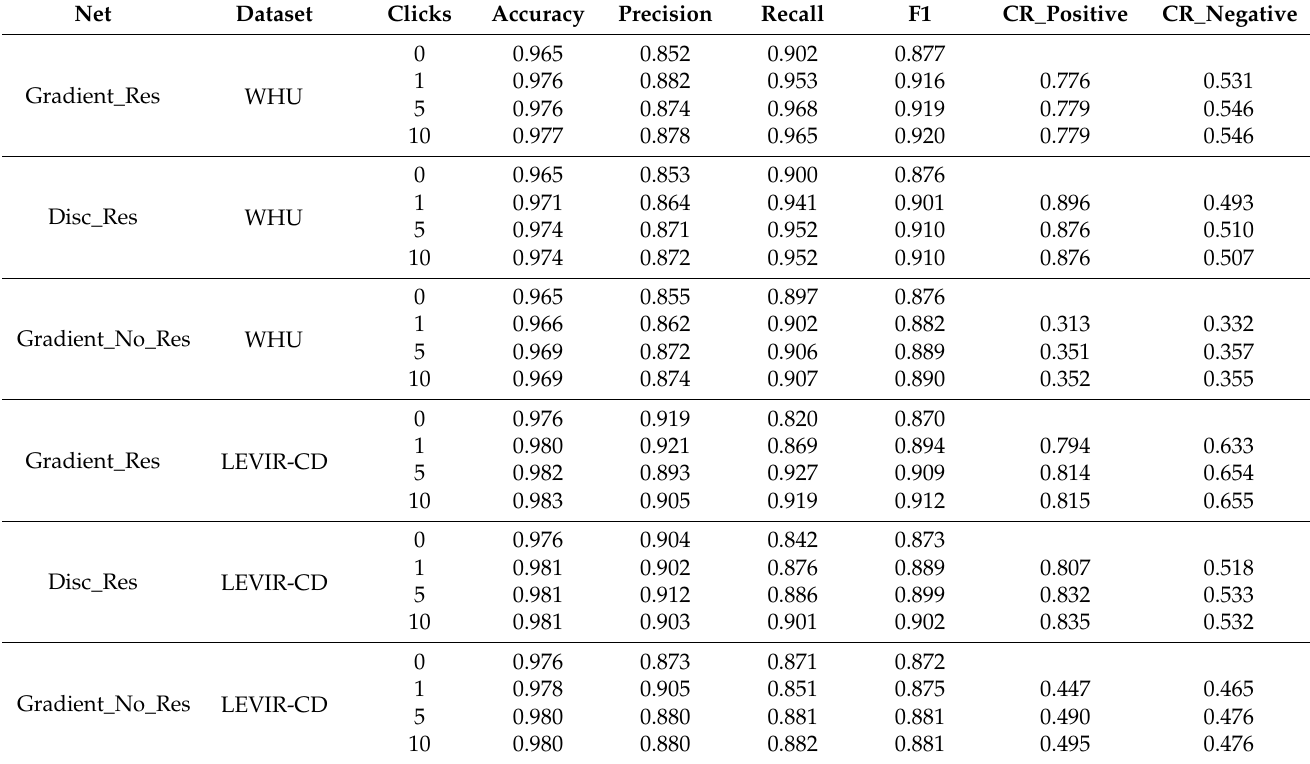
Table 3. Accuracy table of the